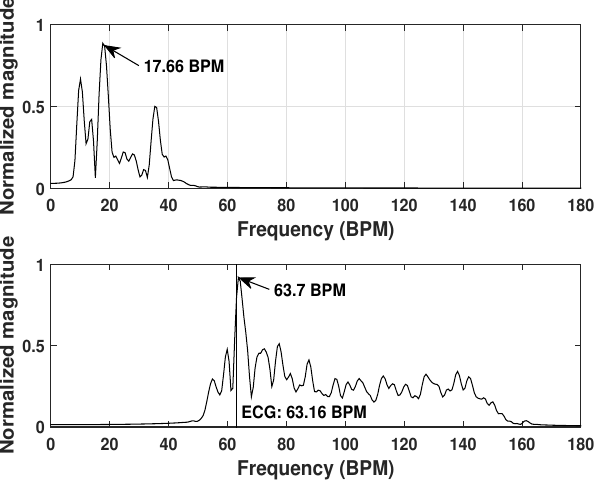
Figure 8. Respiration spectrum ( top ) and heartbeat spectrum ( bottom ) for test example